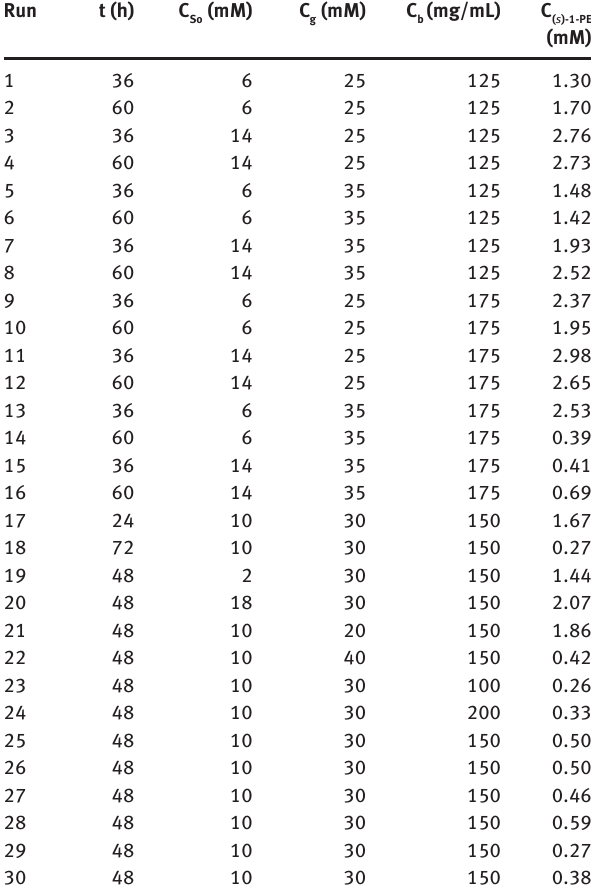
Table 2: The actual values of the experimental conditions and response